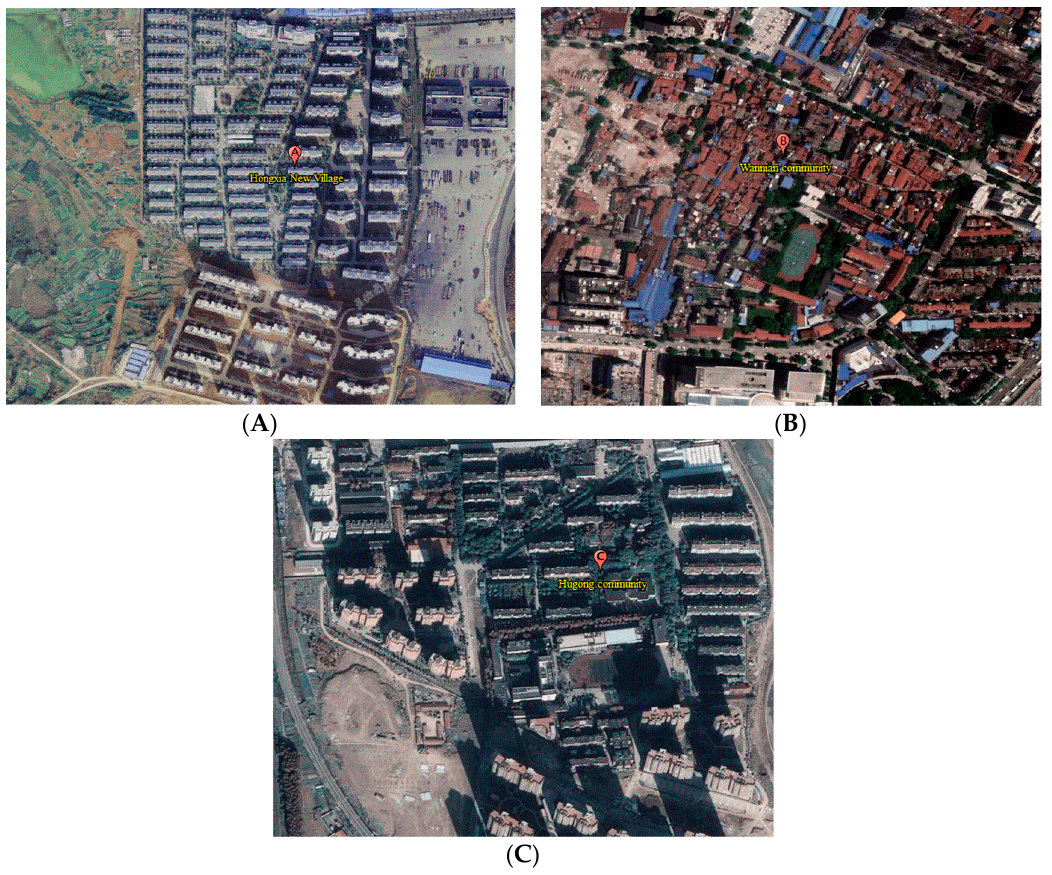
Figure 1. Map of the study area ( A ): Hongxia community; ( B ): Wannian community; ( C ): Hugong